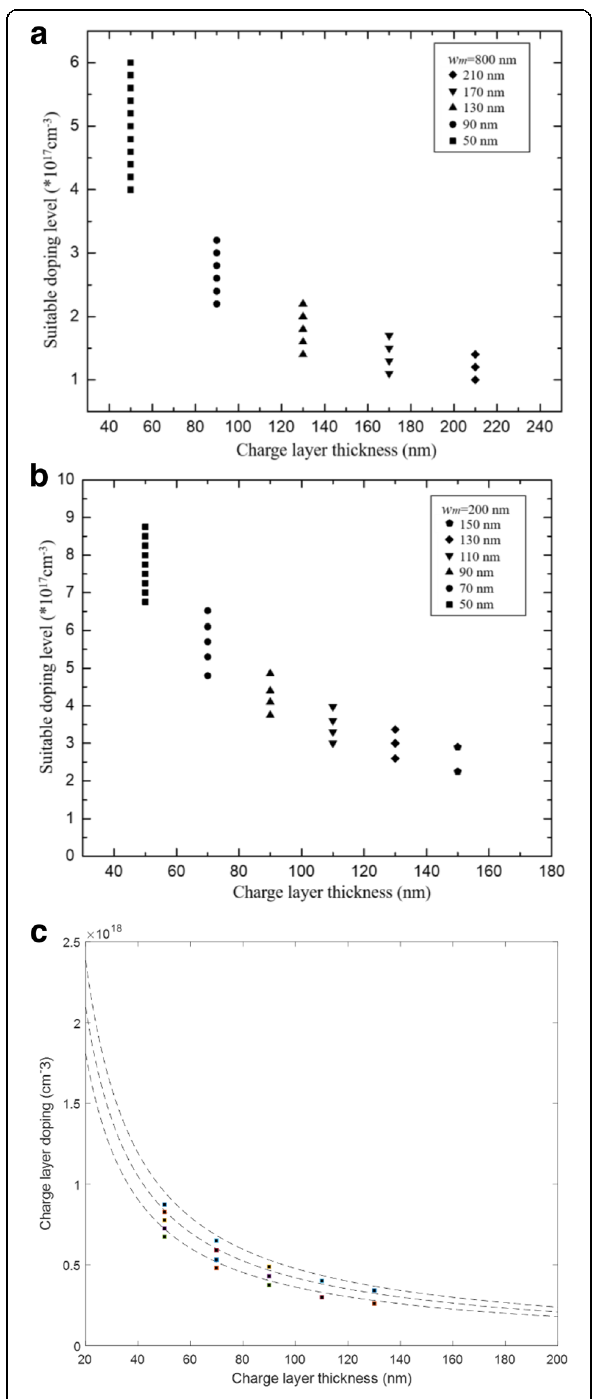
Fig. 9 a Relationship between suitable doping level and thickness of charge layer (APD-1). The thickness of charge layer is 50 nm (black square), 90 nm (black circle), 130 nm (black triangle), 170 nm (black down-pointing triangle), 210 nm (black diamond). a presents the suitable doping level region for different thickness of charge layer. As the charge layer thickness increases, the suitable doping level range in the charge layer decreases. A relatively large doping level range exists in the thin charge layer, and under this doping level range, the device will have a suitable electric field distribution. Apparently, the doping level range is determined by charge layer thickness. b Relationship between suitable doping level and thickness of charge layer (APD-2). The thickness of charge layer is 50 nm (black square), 70 nm (black circle), 90 nm (black triangle), 110 nm (black down-pointing triangle), 130 nm (black diamond), and 150 nm (black pentagon). The figure description of b is similar to a . c Comparison of calculated results in Fig. 2 and simulated results in Fig. 9b. Dashed line: calculated results. Closed symbols: simulated results (black square). c presents the comparison of calculated results in Fig. 2 and simulated results in Fig. 9b. The calculated results and simulated results correspond